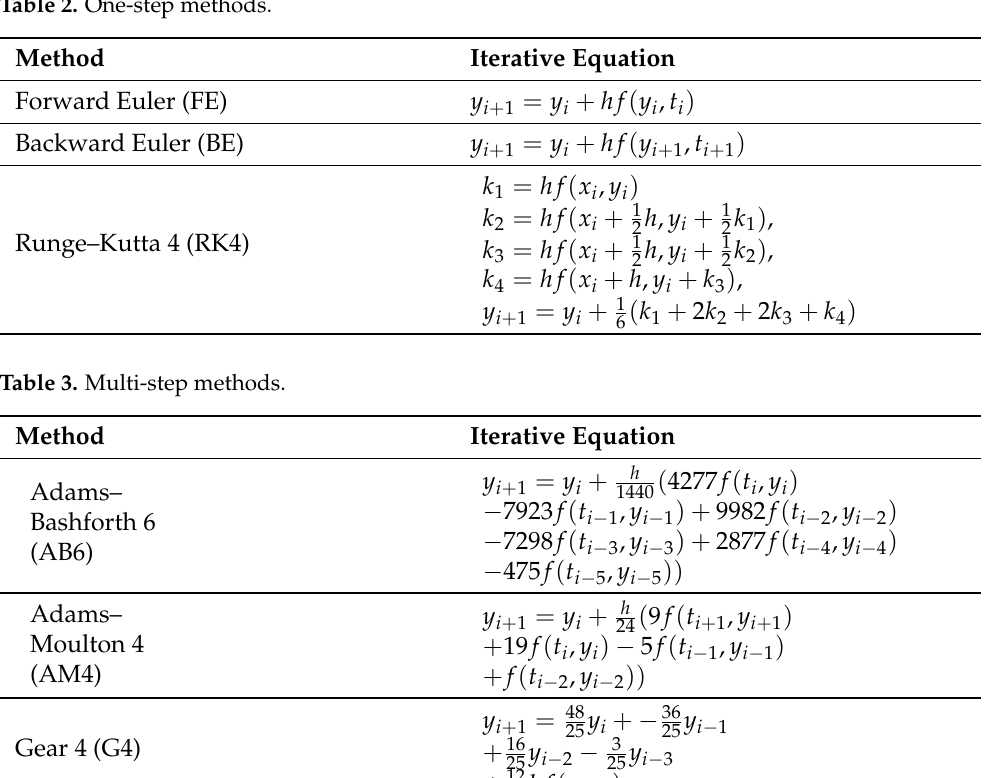
Table 2. One-step methods.